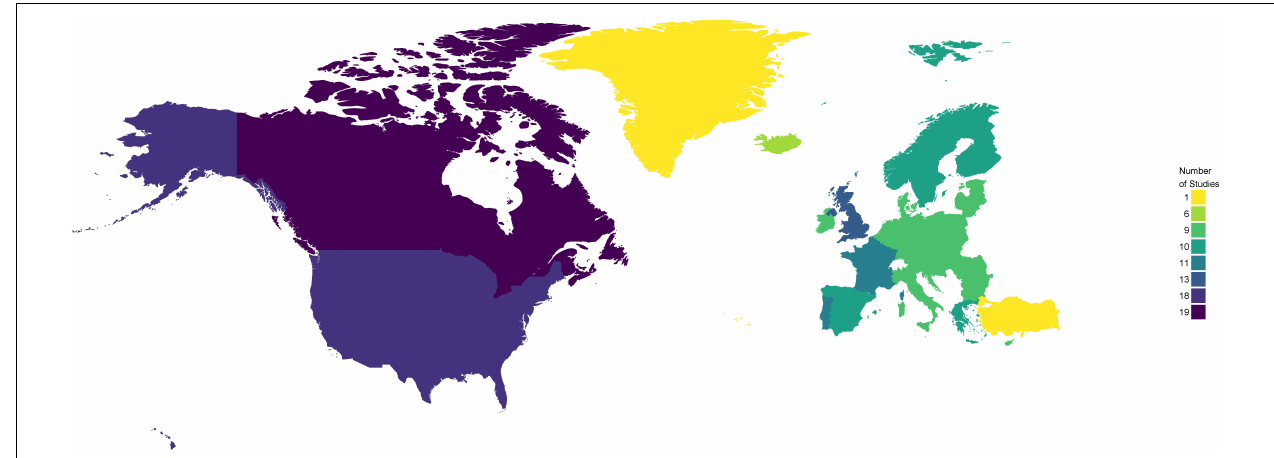
FIGURE 1 | Geographic coverage of literature on women’s fisheries participation. Note that the scale is not continuous but rather accommodates the actual number of studies by country: Azores, Finland, Greenland, Turkey, Iceland, Austria, Belgium, Bulgaria, Croatia, Cyprus, Czech Republic, Denmark, Estonia, France, Germany, Greece, Hungary, Ireland, Italy, Latvia, Lithuania, Luxembourg, Malta, Netherlands, Poland, Portugal, Romania, Slovakia, Slovenia, Spain, Norway, The United Kingdom, United States, and Canada. All EU countries were included for studies dedicated to reviewing gender in fisheries across the whole EU or "Europe" in general with EU country